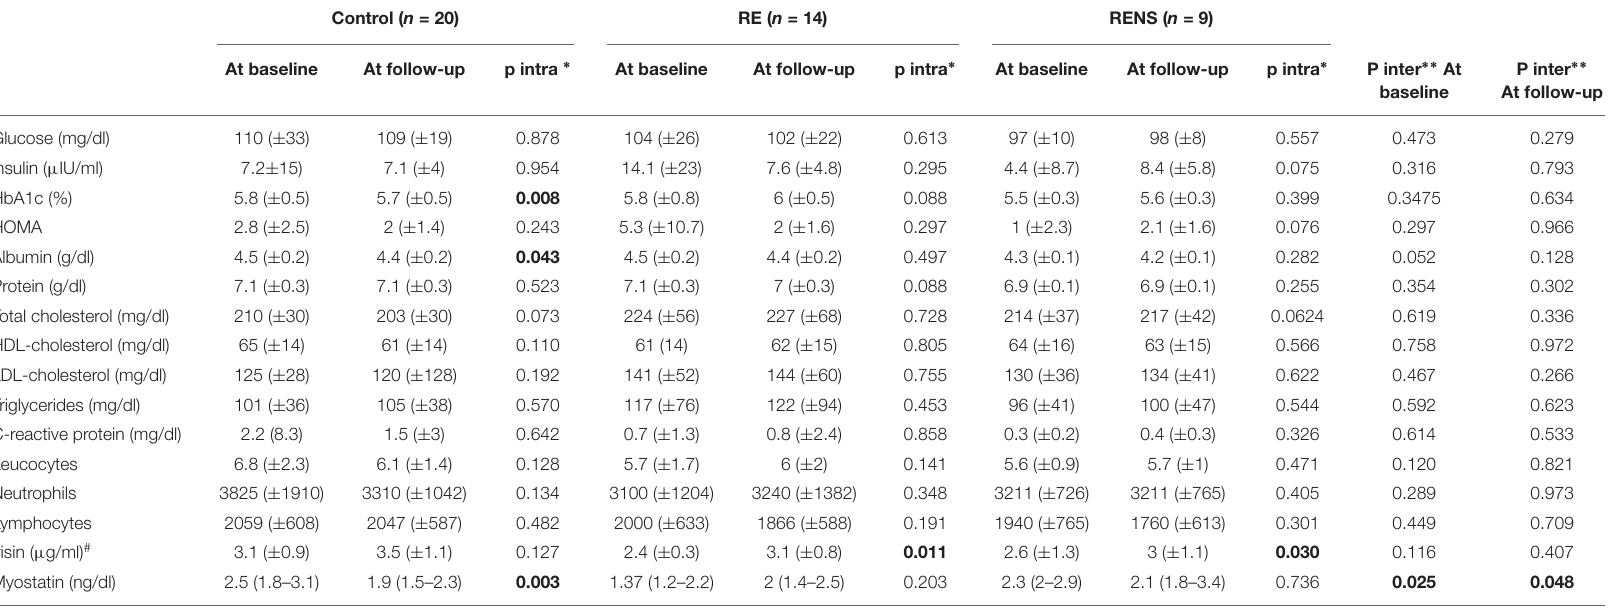
TABLE 2 | Clinical and biochemical parameters in study